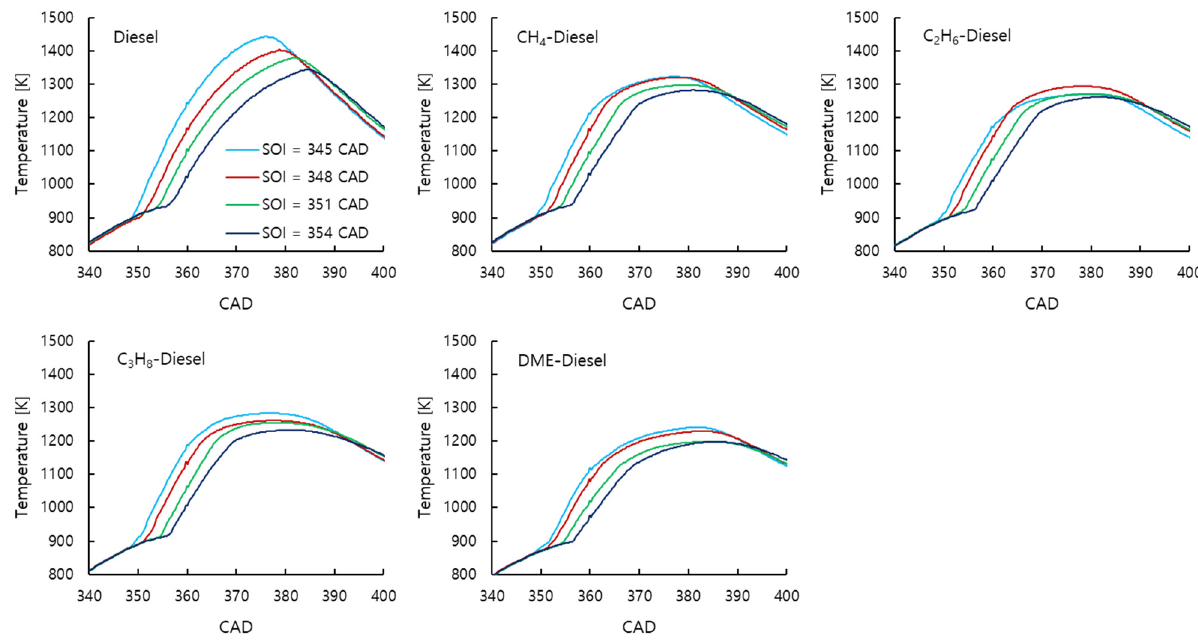
Figure 22. In-cylinder temperature diagrams according to pilot SOI angles in all combustion modes.